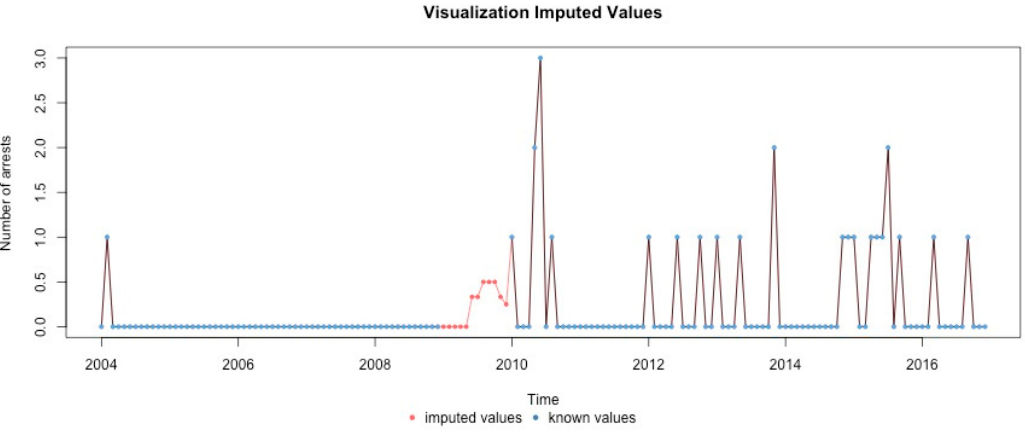
Figure A9. Precursor Vietnam nationals arrests 2004–2016 in the Czech Republic—imputed missing values.